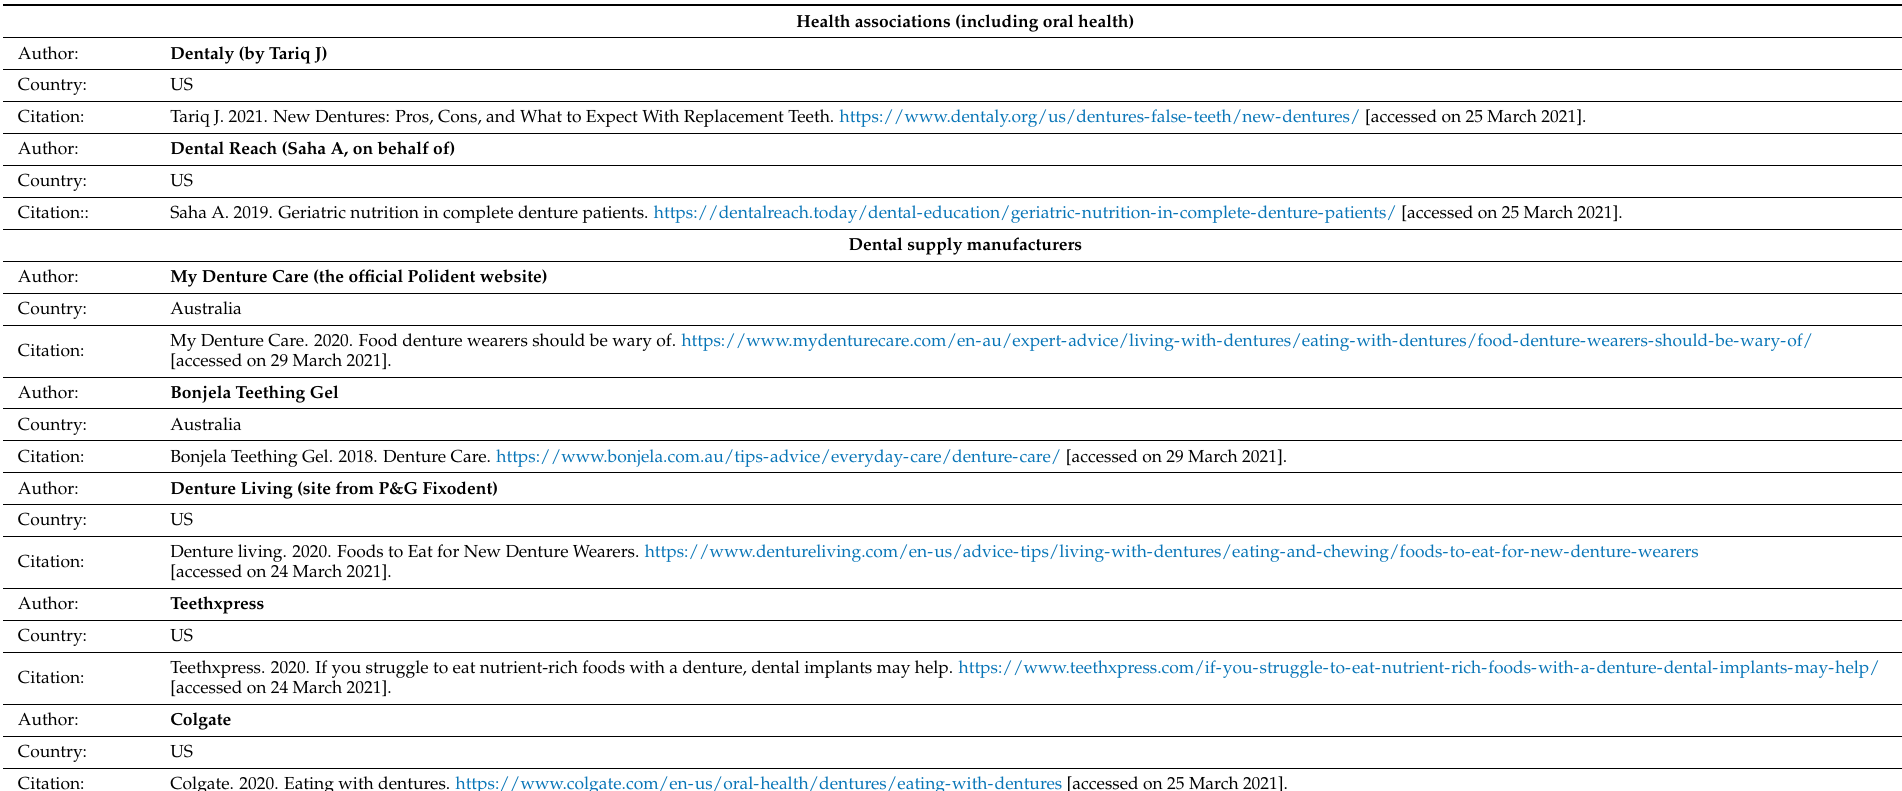
Health associations (including oral